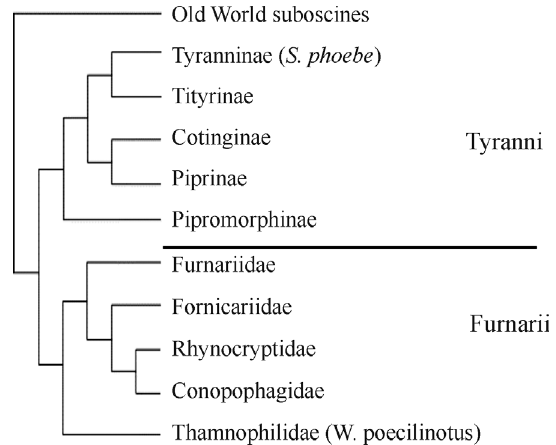
Figure 3 - Phylogenetic tree of the suborder suboscines. New world suboscines are divided into the infraorders Tyranni and Furnarii. Putative RA-like nuclei have been found in S. phoebe (Liu et al. , 2013) and in Willisornis poecilinotus (this